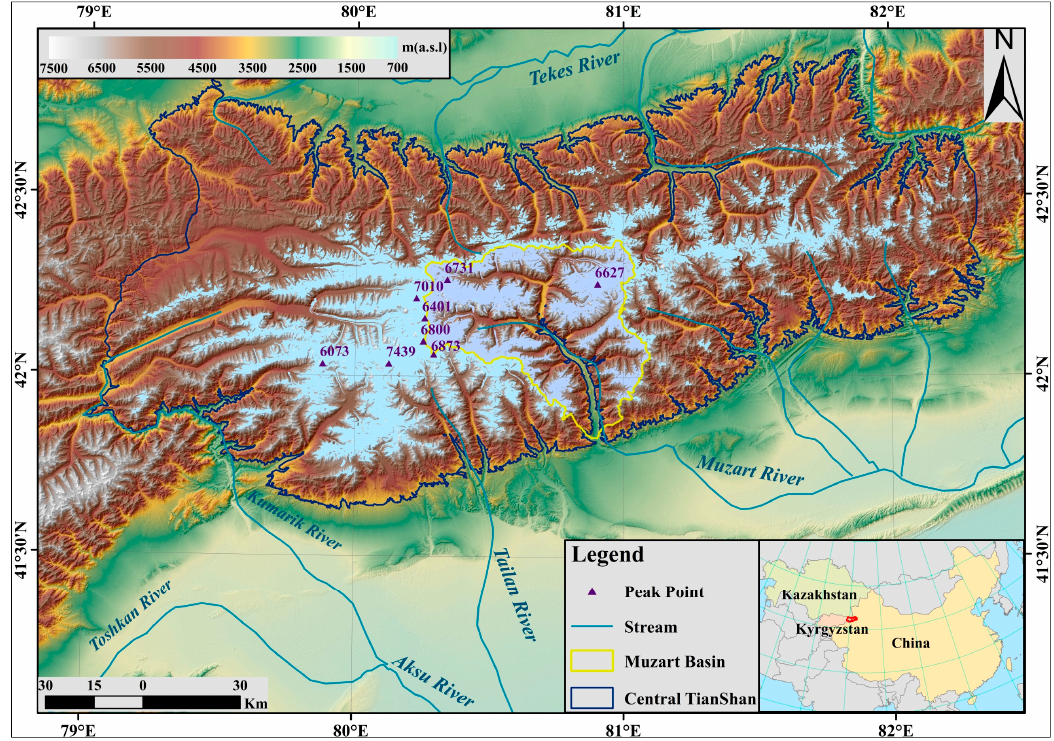
Figure 2. Study area in Central Tianshan Mountain and the Muzart Glacier catchment (yellow line) of the upper Muzart River Basin, China. The analyzing areas are constrained by the 2500 m elevation contour (dark blue line).